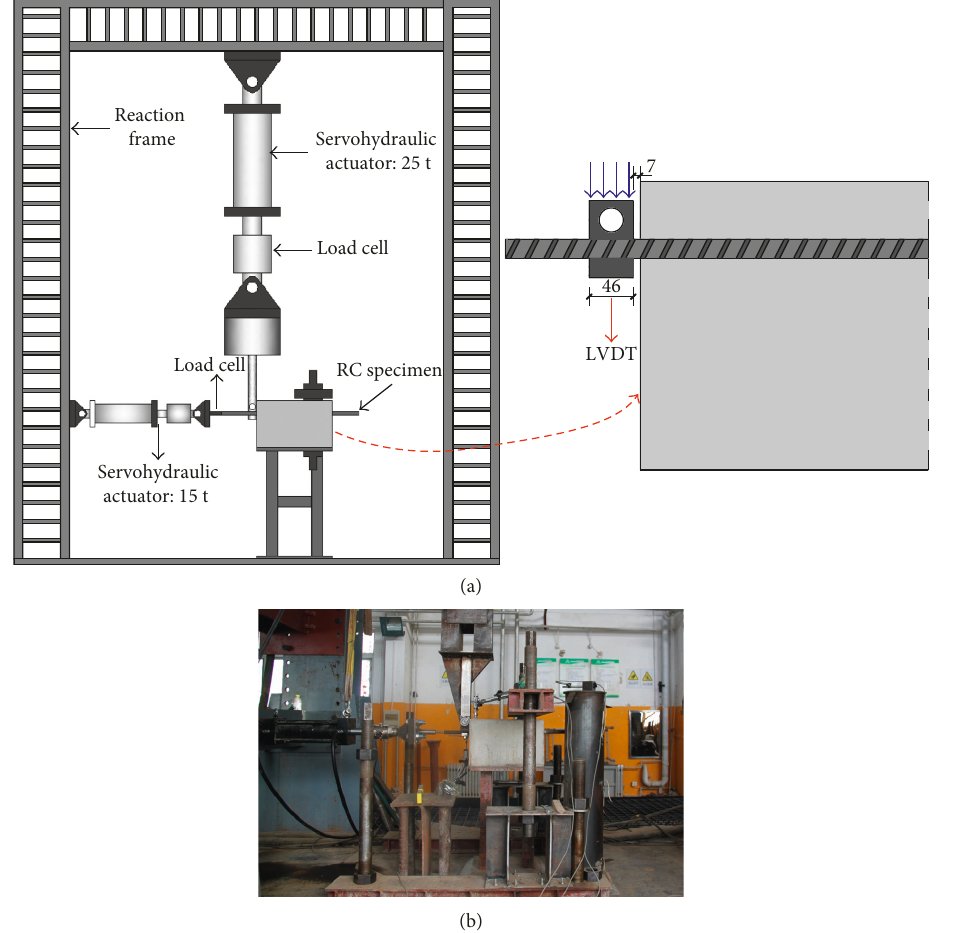
Figure 2: Schematic of test setup: (a) loading scheme; (b) measurement scheme.